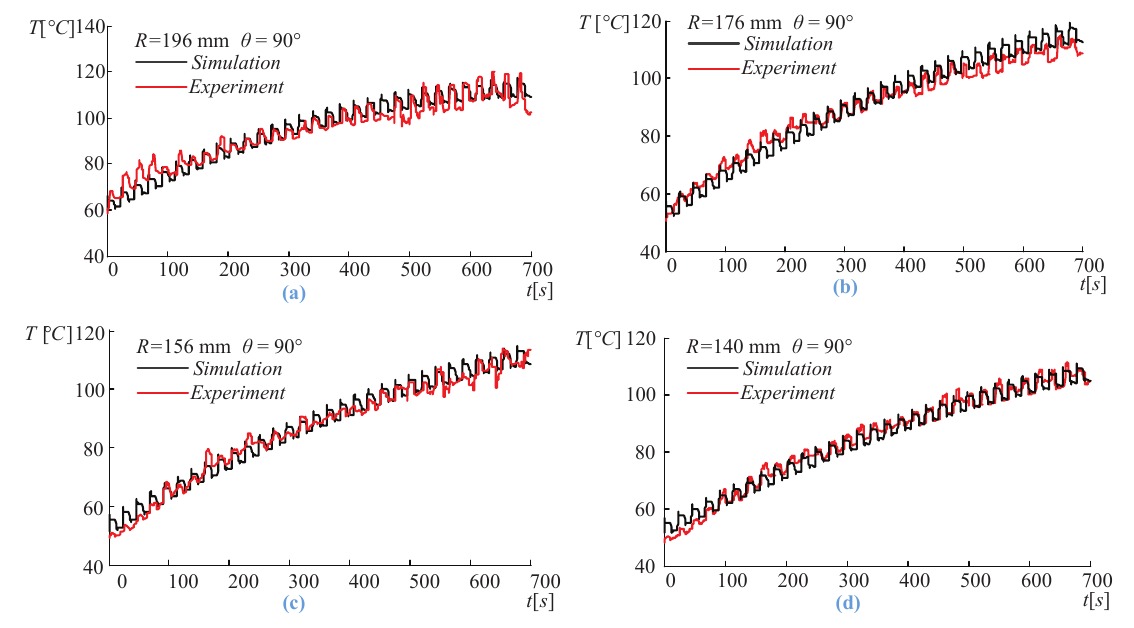
Figure 8. Temperature variation at different radii on the line d .